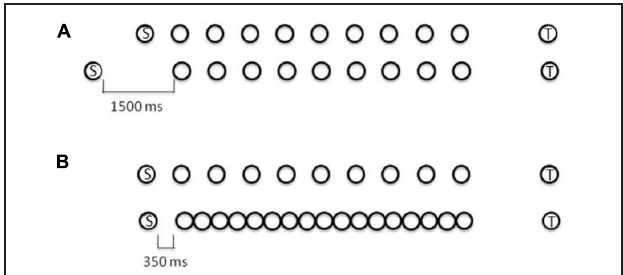
Figure 5 . In the first case ( Figure 5A ), we compared pitch dis- crimination performance under conditions where the timing of the tones was the same as that used in the original